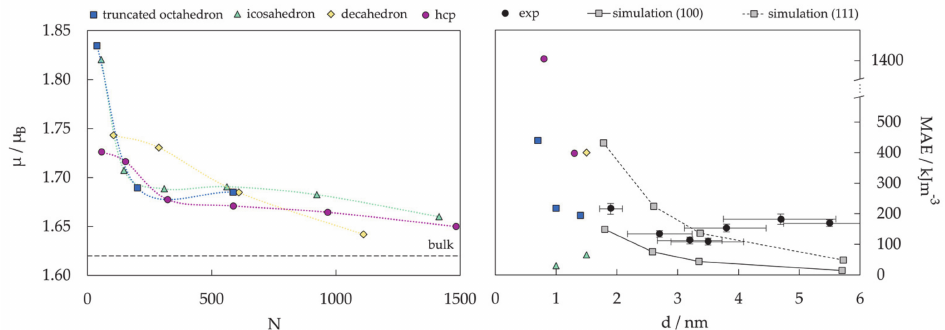
Figure 15. DFT-predicted progression of average magnetic moment per atom, µ , ( left ) and compari- son between DFT-calculated, experimentally measured, and N é el pair surface correlated magnetic anisotropy energies, MAE, ( right ) with the increase in the size for Co mNPs of varying morphologies. DFT results are taken from Farkaš (2021) [384], and experimental and N é el pair modelling results are taken from Oyarz ú n (2005)